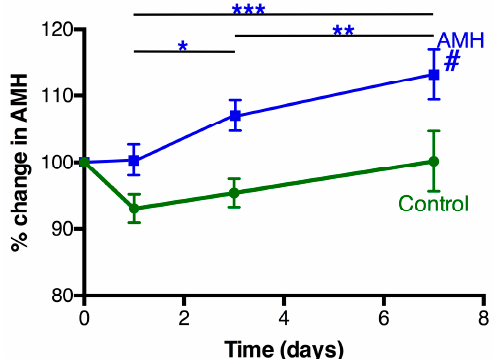
Figure 3. Serum AMH levels in the days following treatment. The women took either a placebo ( n = 22, green circles) or a tablet containing a 50,000 IU of Vit D3 ( n = 27, blue squares) on day 0 and the serum levels of AMH measured at the indicated time points. # There was a significant change in AMH level over time in the Vit D3 group ( p = 0.001), but not in the control group. Pair-wise post-hoc analysis within the Vit D3 group (* p = 0.054; ** p = 0.033; *** p = 0.006).